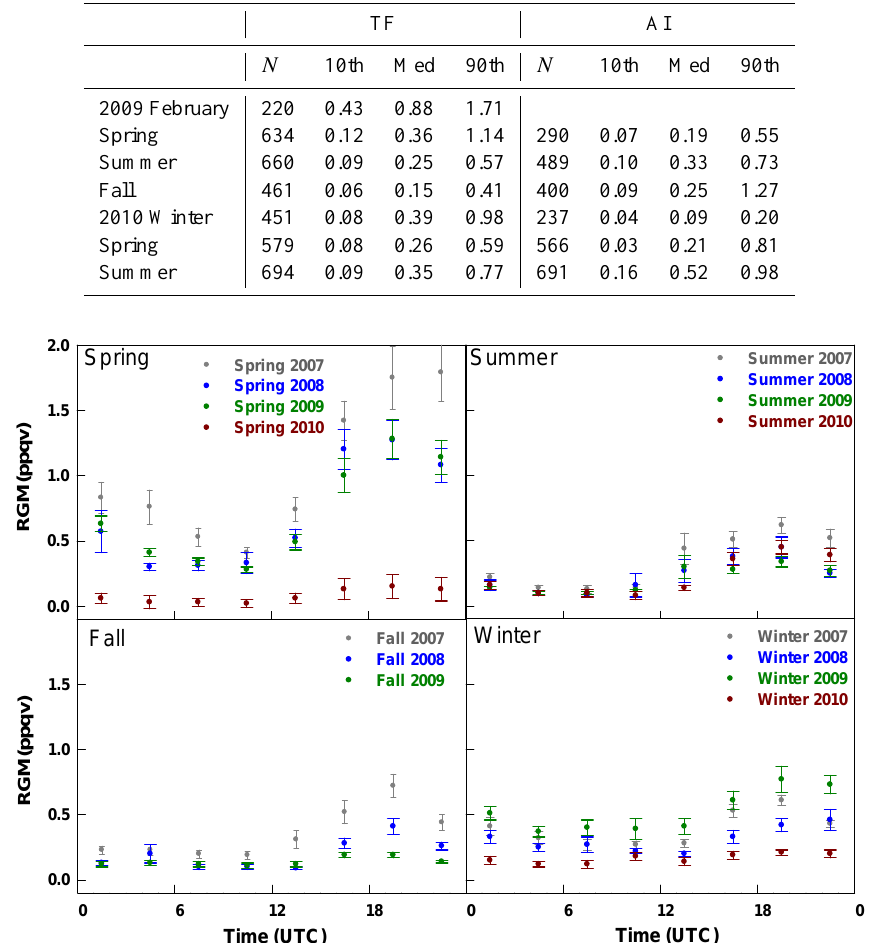
Table 3. The 10th, 50th, and 90th percentile values (ppqv) of Hg P at TF and AI.